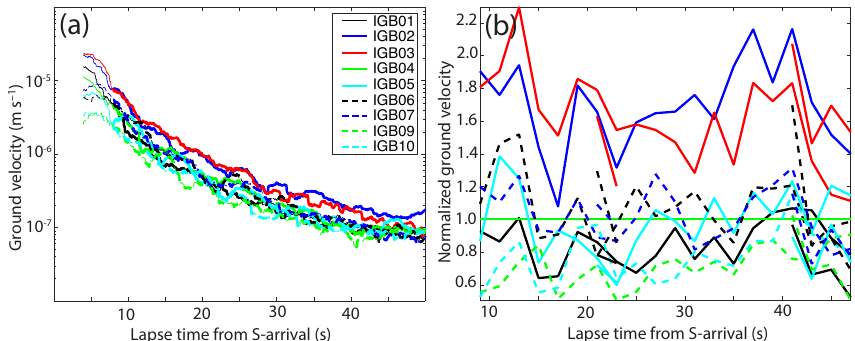
Figure 12. Coda amplification analysis. (a) S-wave coda envelopes of an M 2.2 earthquake on 15 July 2011 (epicentral distance: 12km). Bold lines indicate lapse times greater than twice the S arrival time. (b) Coda amplification with respect to station IGB04 using signals of the three earthquakes listed in Table